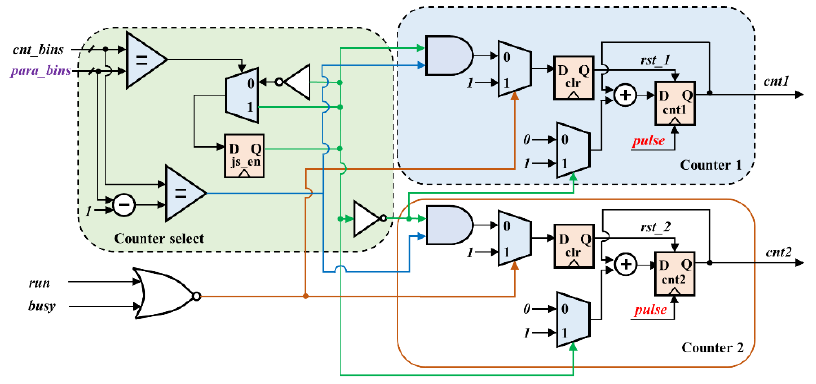
Figure 6. The logic structure diagram of the counting module.